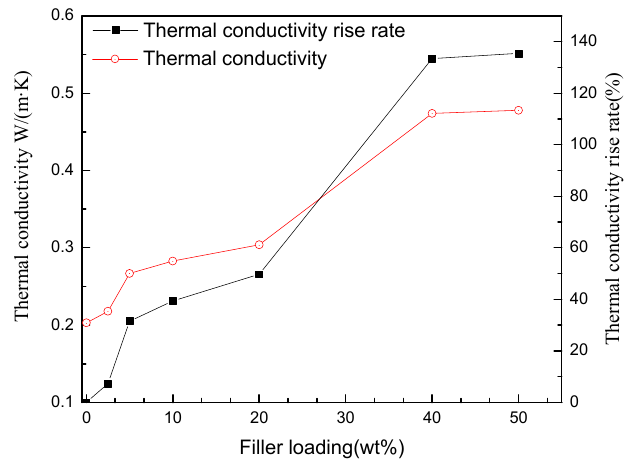
Figure 5. Thermal conductivity versus nano-h-BN content of RIP.